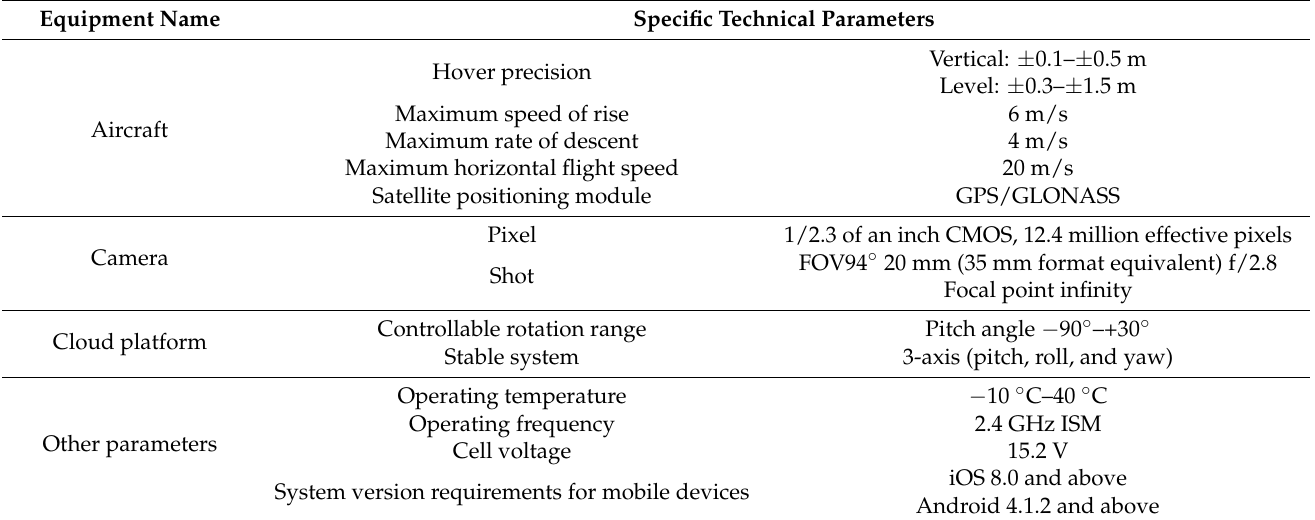
Table 1. The specific parameters of the DJI Phantom 4.